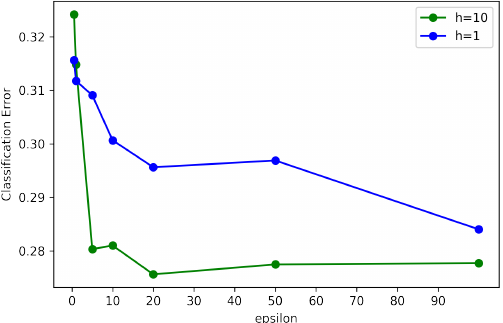
Figure 9. The classification errors for different (cid:101) ( silo number = 4 ) . Overall, the FedVoting process chooses the DP-protected decision trees with the smallest validation error into the final ensemble of federated GBDTs in each iteration. The degree of privacy protection can be set by the parameter (cid:101) with the heterogeneous method. For different levels of privacy protection, FedVoting can acquire the model with the